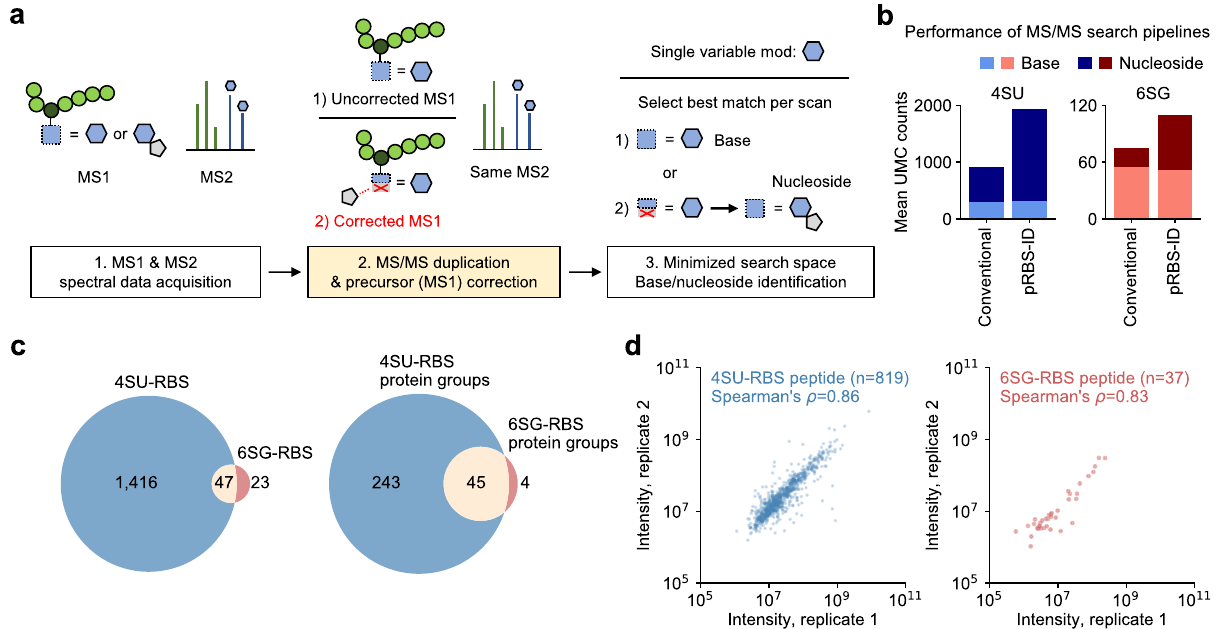
Fig. 2 Robust PAR-RBS mapping by pRBS-ID. a Schematic of the MS/MS search pipeline for pRBS-ID. Following MS/MS spectra acquisition, each MS2 scan is duplicated. One is left unaltered ( “ Uncorrected MS1 ” ), while the other ’ s precursor mass is corrected to account for the ribose neutral loss ( “ Corrected MS1 ” ). The spectra are together searched against a target-decoy database, with a single variable modi fi cation of the base. Finally, a single best match is chosen for each scan. This allows for the simultaneous identi fi cation of peptides with base or nucleoside adducts. b Comparison of unique mass class (UMC) identi fi cation counts between conventional MS/MS search and pRBS-ID. In the former, variable modi fi cations were de fi ned as either base or nucleoside, without precursor correction considering ribose loss. c Comparison of identi fi ed 4SU-RBSs and 6SG-RBSs (left) or the respective protein groups (right). d MS1 intensity-based label-free quanti fi cation 24 of peptides containing 4SU-RBS (left) or 6SG-RBS (right) co-identi fi ed in replicate experiments. Spearman ’ s correlation coef fi cients were calculated and rounded up to the second decimal